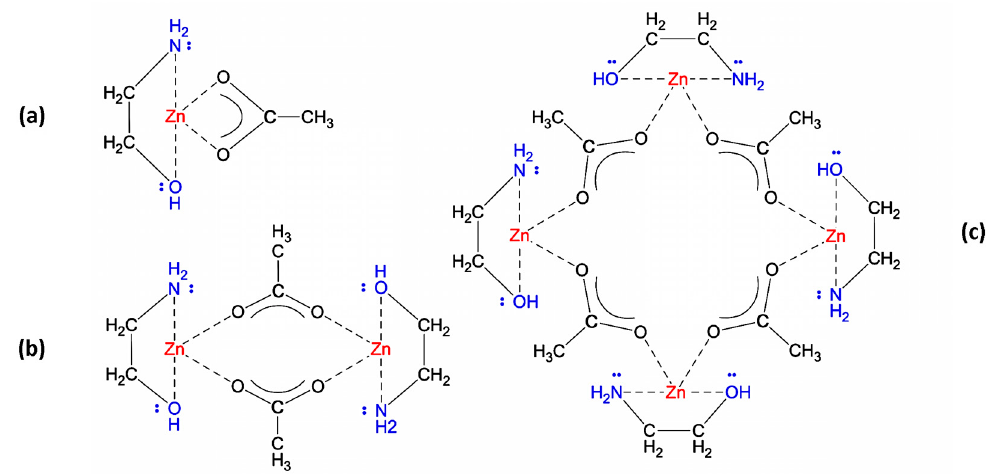
Figure 8. Proposed structural formula of the complex compound in ( a ) a monomer, ( b ) a dimer, and ( c ) tetramer forms.